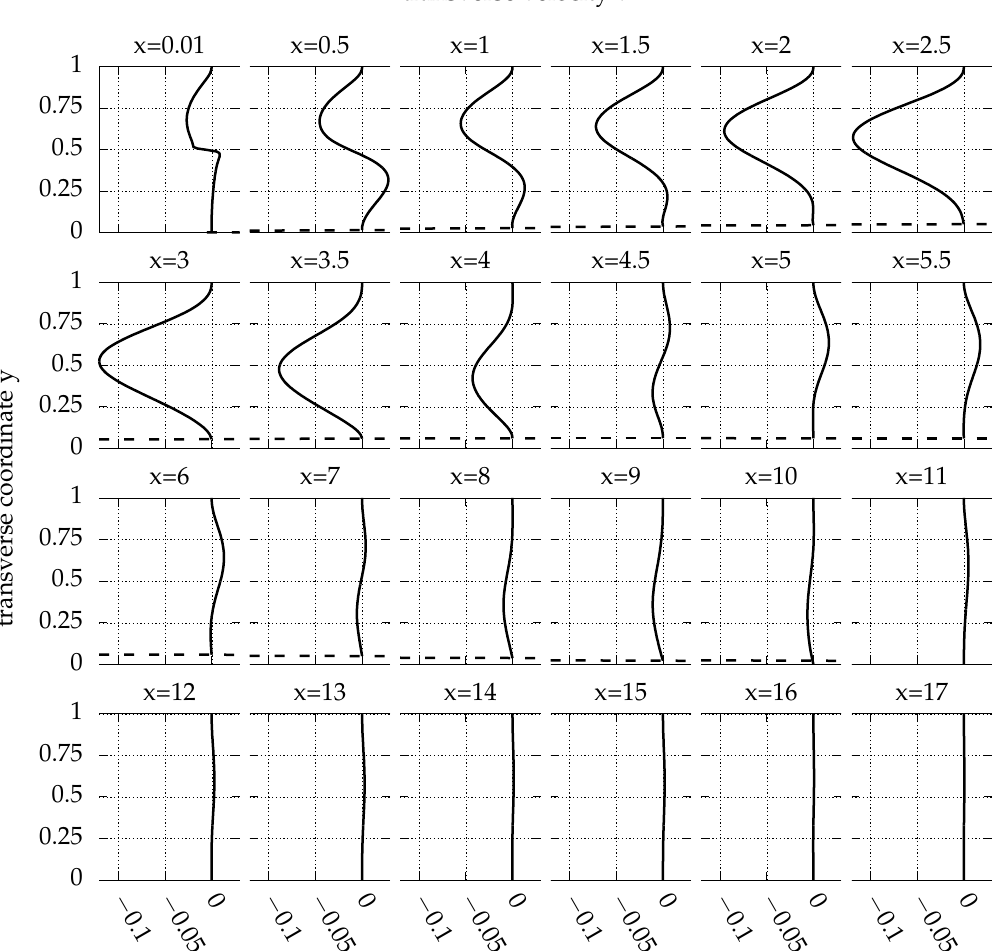
Figure 7. Transverse velocity profiles for successive positions x downstream the step, for BFS with control portion l = 10 of elastic membrane bottom wall, with T m = 55 and p e = 0.525, at steady flow with Re = 400 (0 ≤ x ≤ 17). The membrane shape is also depicted in non-dimensional units at the bottom (dashed